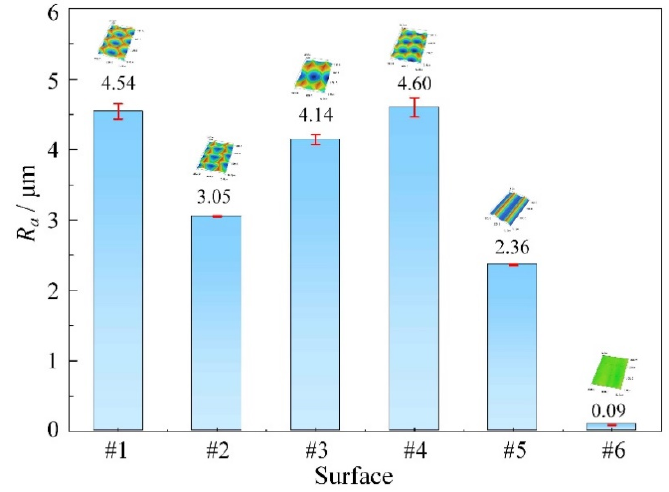
Figure 7. Surface roughness of different surfaces.